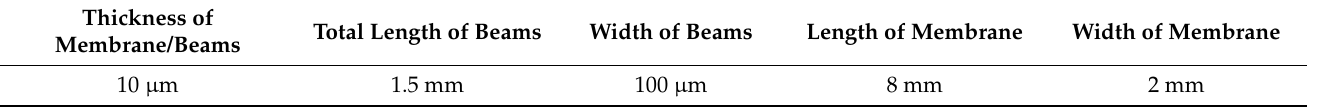
Table 1. Design parameters of the MOEMS parabolically deformable cylinder MAAM device. Thickness